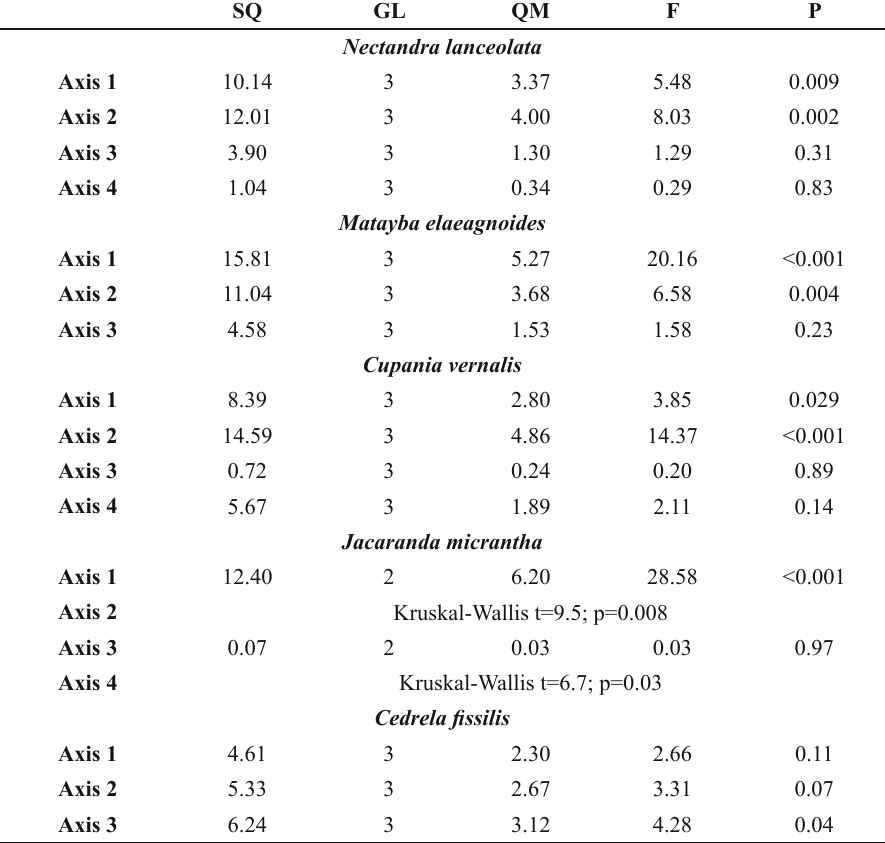
One-way ANOVA (season) made with the scores of the PCA axes that had eigenvalues > 1 (Kaiser criterion). Legend: SS: sum of squares; DF: degrees of freedom; QM: mean square; F: F values and P: signi fi